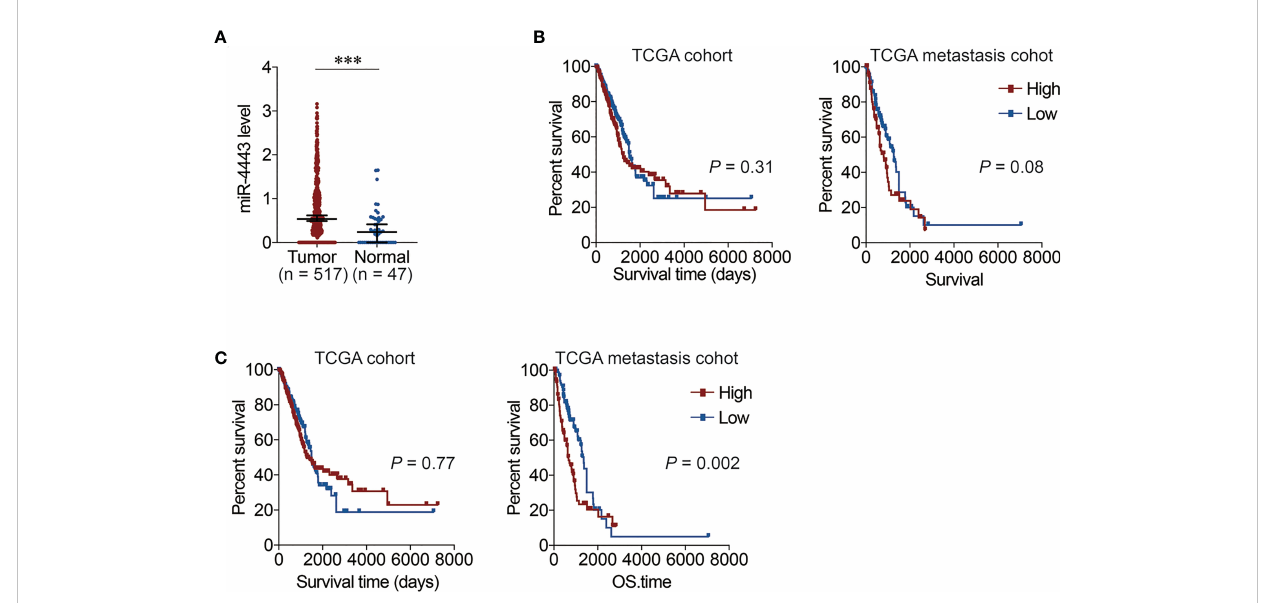
FIGURE 6 The relationship between the expression of miR-4443 with lung cancer progression in TCGA data. (A) . The expression of miR-4443 in TCGA lung adenocarcinoma (LUAD) data. Comparisons were made using Student ’ s t test. *** P < 0.001. (B) . The Kaplan-Meier overall survival curves of TCGA LUAD patients grouped by miR-4443 in all patients (left panel) or metastasis patients (right panel). The high and low group are divided by the median value of miR-4443. (C) . The Kaplan-Meier overall survival curves of TCGA LUAD patients grouped by miR-4443 in all patients (left panel) or metastasis patients (right panel). The high and low group are divided by the median value of miR-4443 with normalization by the proportion of macrophages calculated using CIBERSORT (lower panel). The signi fi cant was calculated using the two-sided log-rank